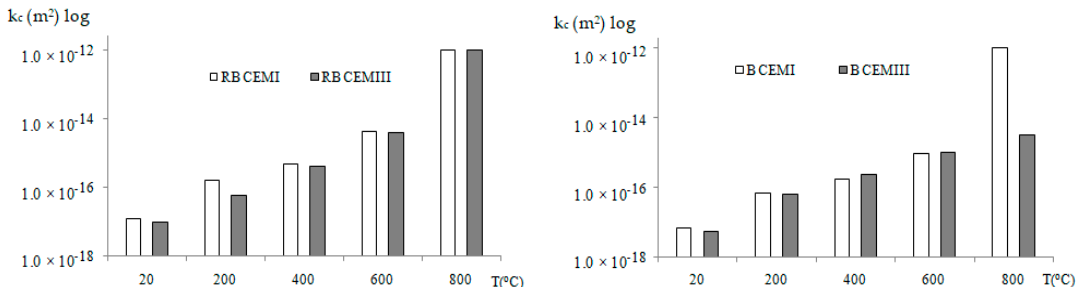
Figure 7. E ff ect of heating on the permeability of the test materials: RB CEMI and RB CEMIII, B CEMI